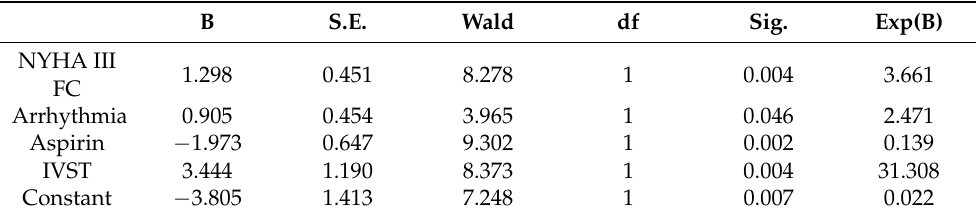
Table 5. Association of variables before surgery with unfavorable outcome (MACE + cardiovascular hospitalization) 18 months after CABG (binary logistic regression analysis, forward likelihood ratio).